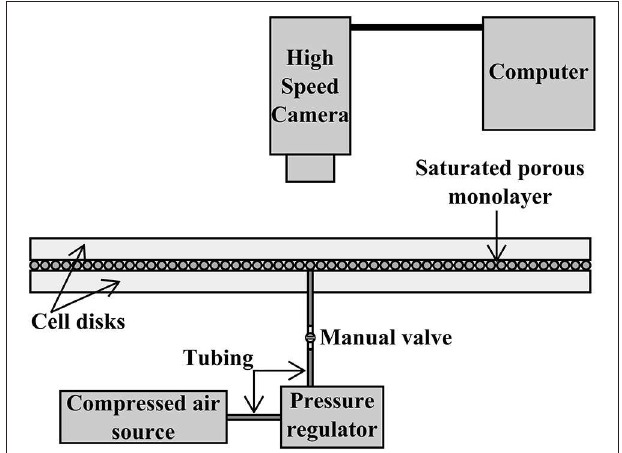
FIGURE 1 | Sketch of the experimental setup for the two-phase flow experiments: The horizontal cell consists of two transparent disks of 40 cm in diameter, clamped together (not shown) but separated by a small gap. The gap is big enough to accommodate a saturated porous monolayer of 1.0mm beads. This sketch represents the non-deformable system, however the setup is the same for the other boundary conditions as well. A compressed air source is connected to an injection hole in the center of the bottom disk, and a pressure regulator is used to adjust the constant injection pressure between 25 and 100hPa. During air injection, the high speed camera situated directly above the cell captures the invasion at a framerate of 125 frames per